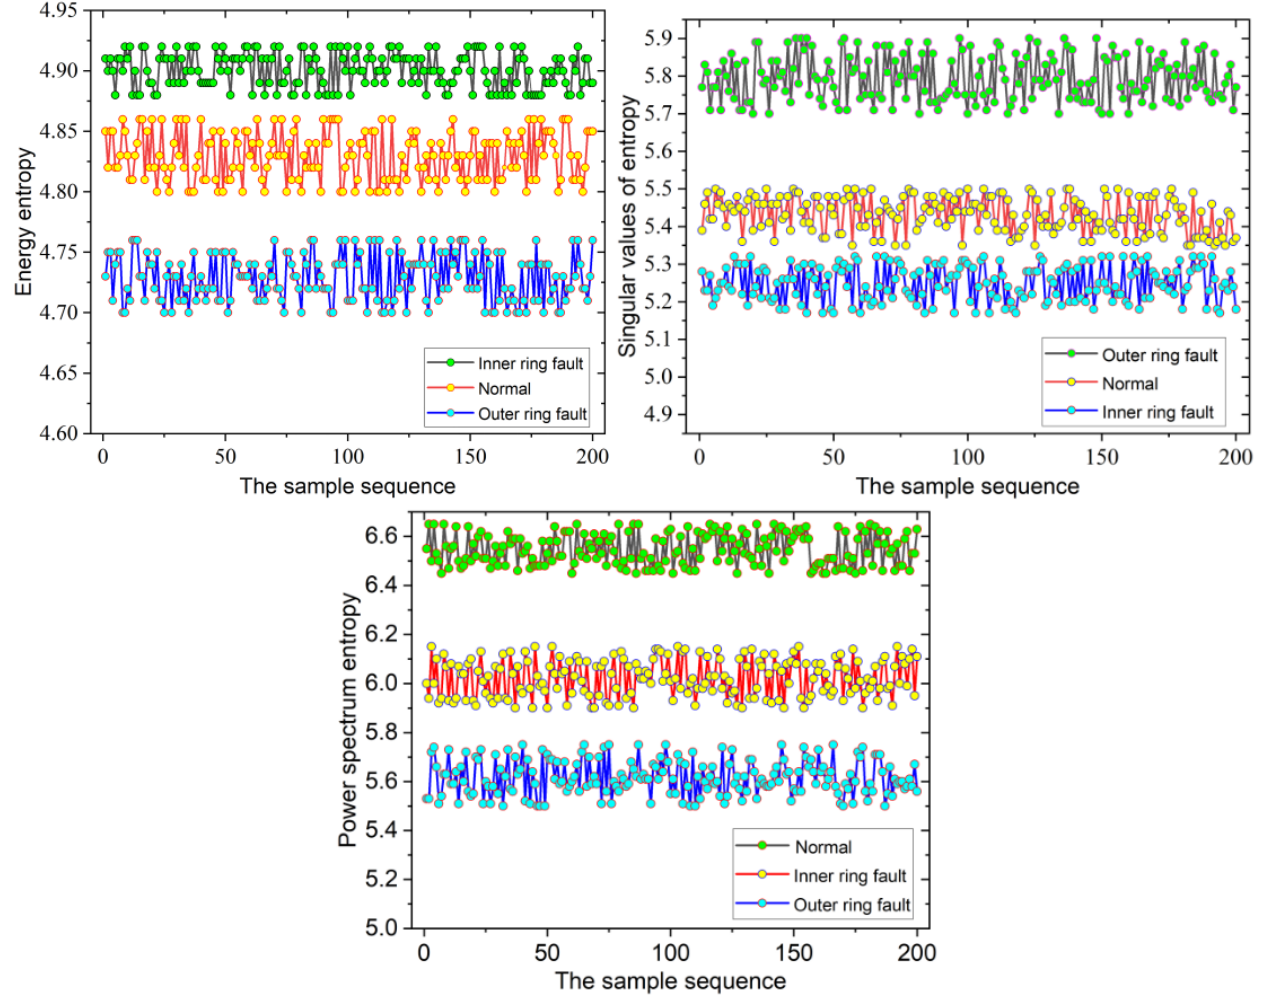
Figure 10. Distributions of energy entropy, singular value entropy, and power spectral entropy in different conditions.